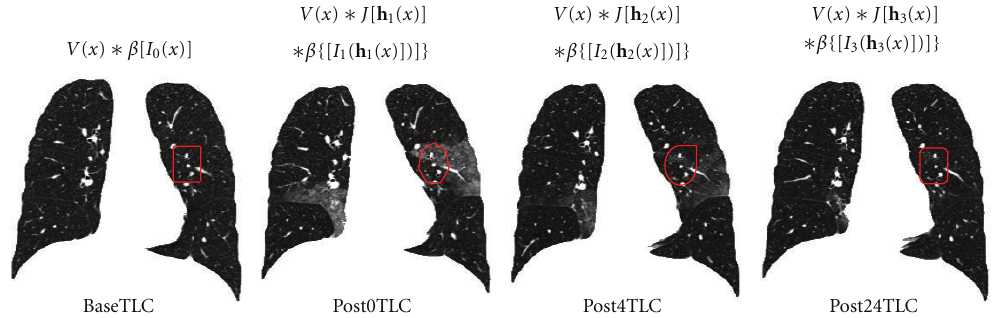
Figure 5: Illustration of the method utilizing inter-phase registration results to track tissue volume across four di ff erent phases. The region within the red rectangular in baseTLC is assumed to deform to the regions enclosed by red curves in images of post